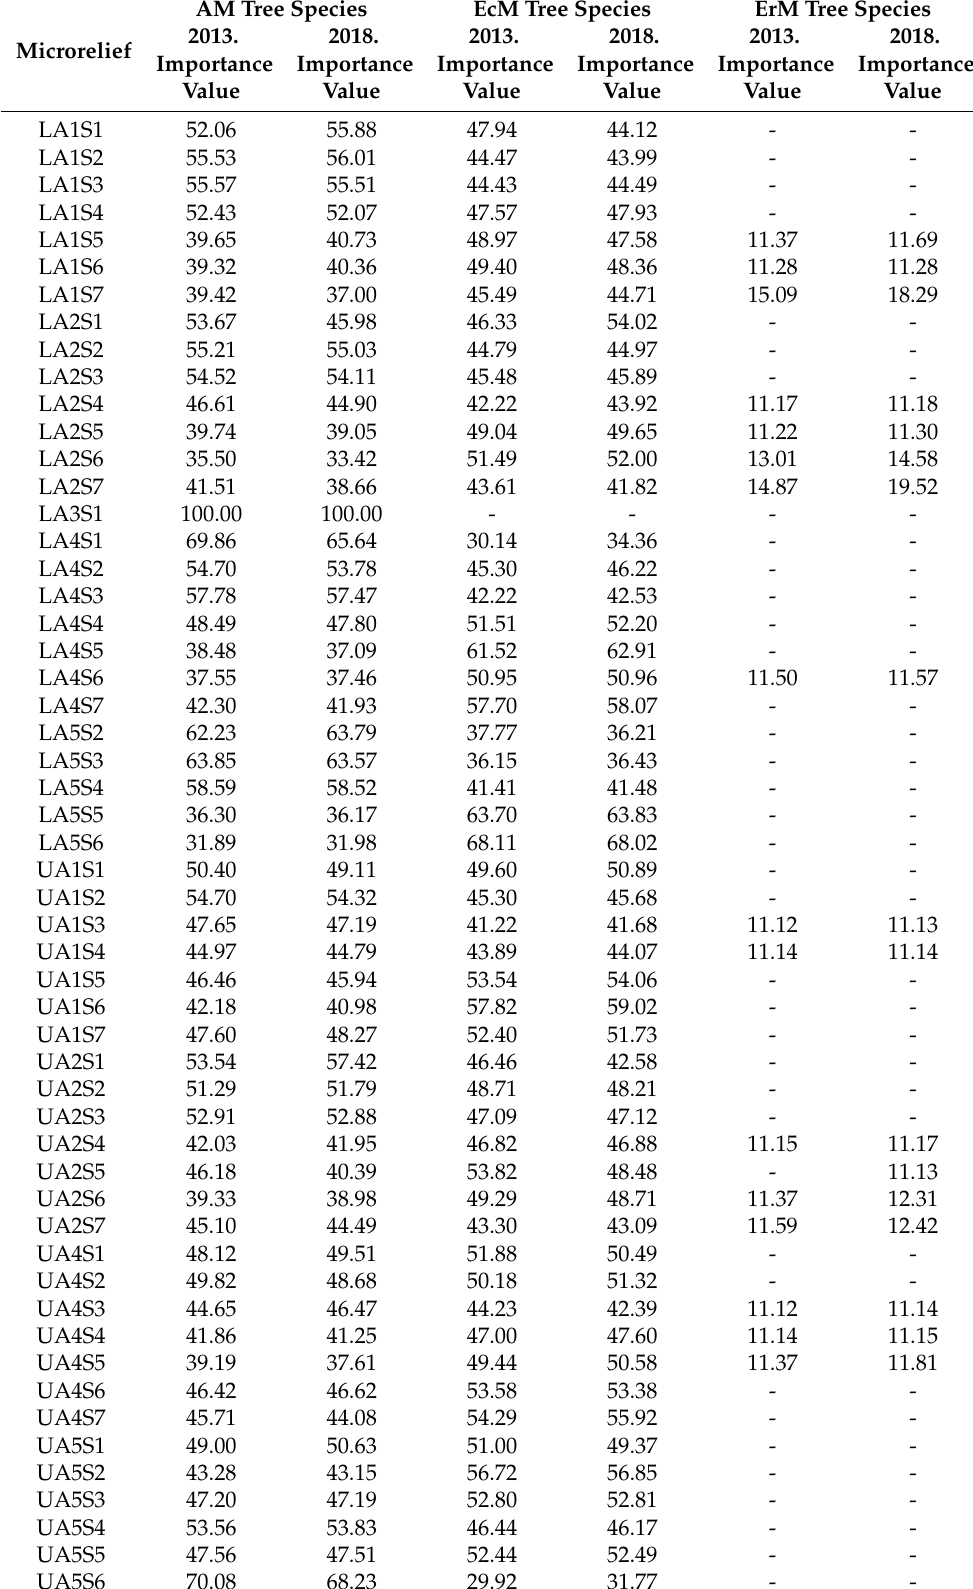
Table A2. Importance values of tree species with different mycorrhizal types in different microto-